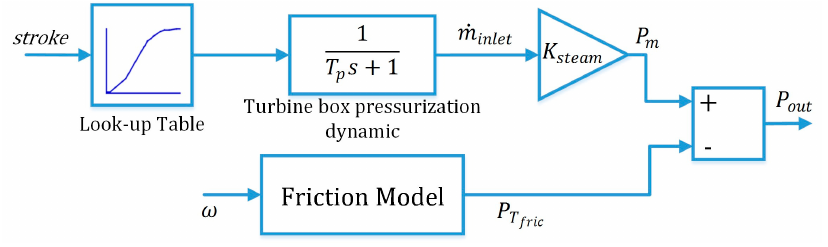
Figure 3. Simplified Simulink model of a turbine.